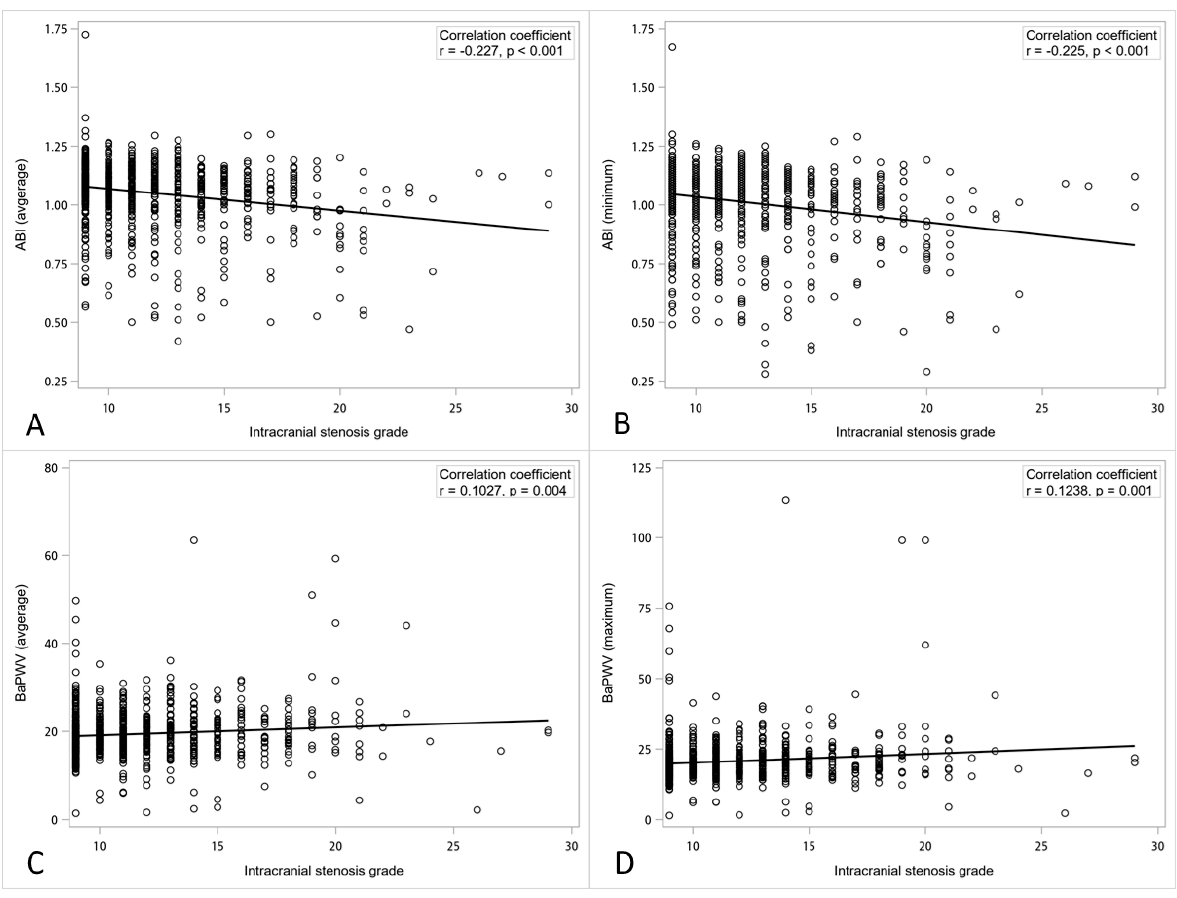
Figure 2. Relationship between the ABI/baPWV and intracranial vessel stenosis. ( A , B ) The correla- tion between the average and minimum ABI and intracranial vessel stenosis. ( C , D ) The correlation between the average and maximum baPWV and intracranial vessel stenosis.